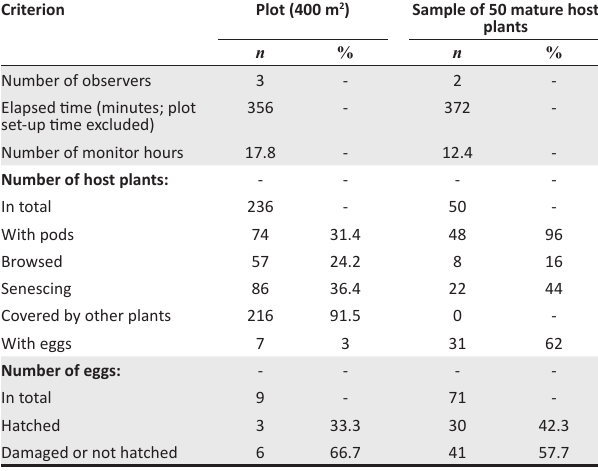
FIGURE 6: Distribution of patches of the host plant Indigofera woodii var. laxa in relation to the presence and absence of the host ant Camponotus natalensis on the Stirling farm study TABLE 4: Comparison of results from the two monitoring methods employed at The Start in 2006. Criterion